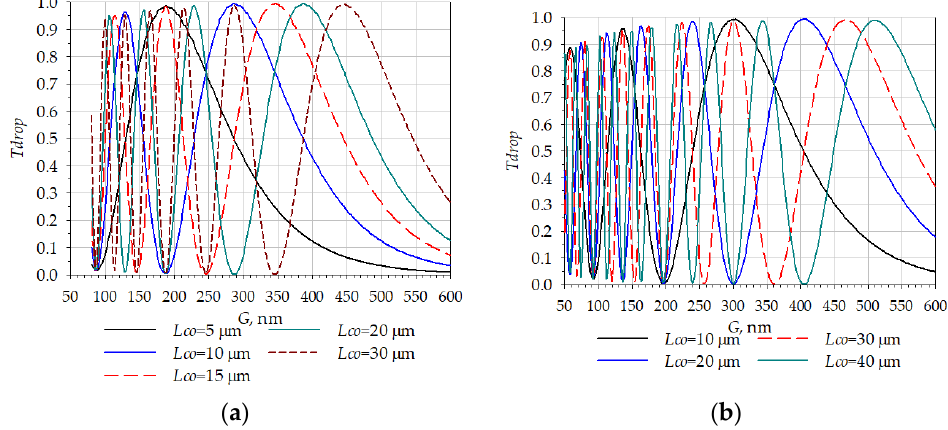
Figure 15. Dependence of the optical transmission coefficient on the gap for the OMT with different-plane waveguides (Scheme 9, movement along axis Z). ( a ) Waveguides with dimensions of 300 × 1000 nm; ( b ) Waveguides with dimensions of 300 × 750 nm.